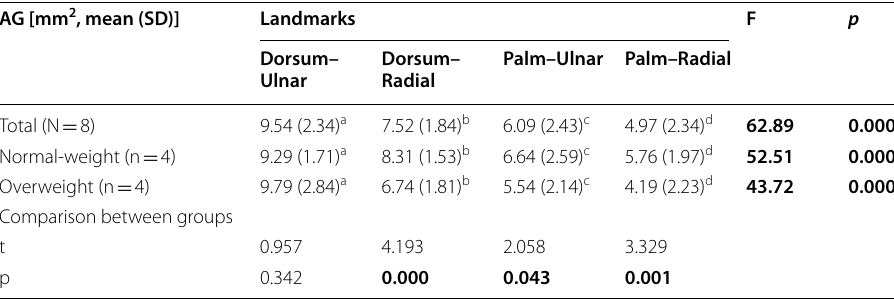
Items in bold: significant t-value; the alphabetical order is the same as the order of mean difference according to the Duncan test AG air gap, SD standard deviation